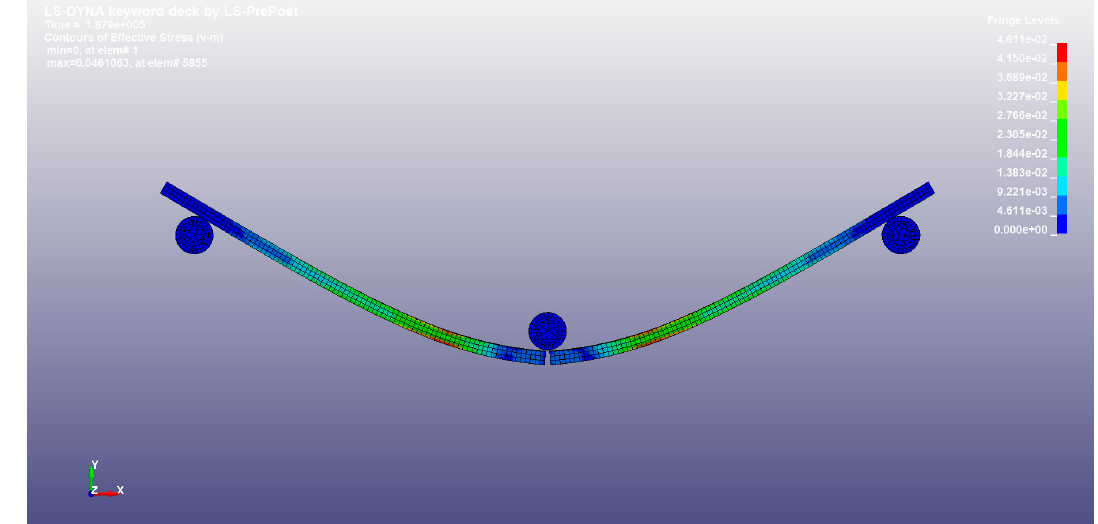
Figure 16. Simulated fractured longitudinal 25% volume fraction specimen.